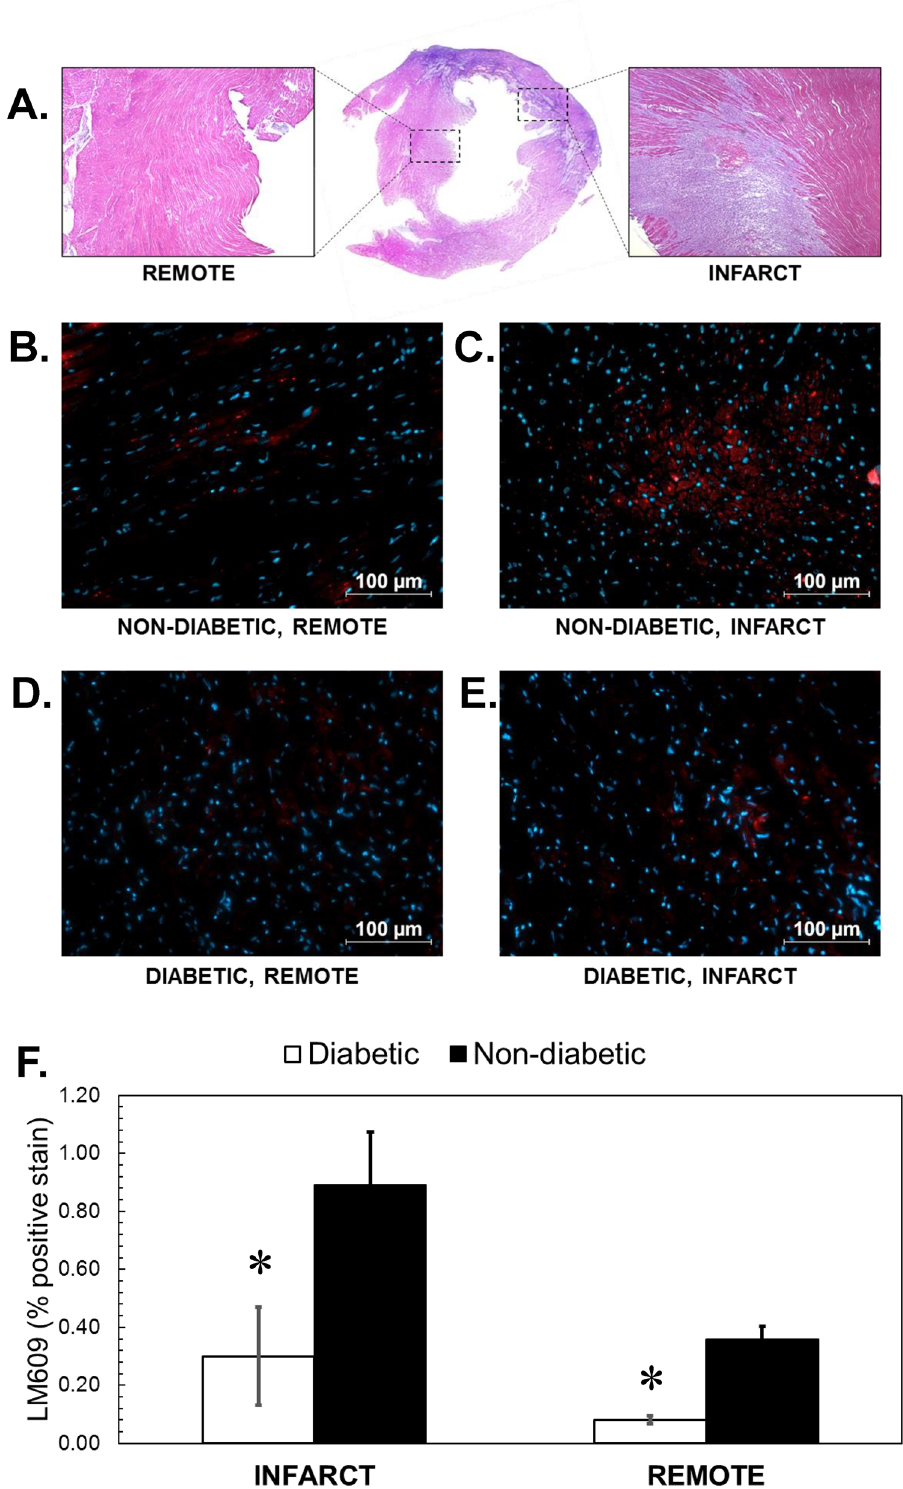
Figure 7. α V β 3 immunohistochemistry. ( A ) A representative H&E stain of the infarct and remote areas of the heart. ( B – E ) representative immunohistochemistry images with LM609 (red) and DAPI (blue). ( F ) Quantification of α V β 3 positive area in stained heart tissue. The non-DM infract tissue showed significant increase in α V β 3 expression relative to DM infract